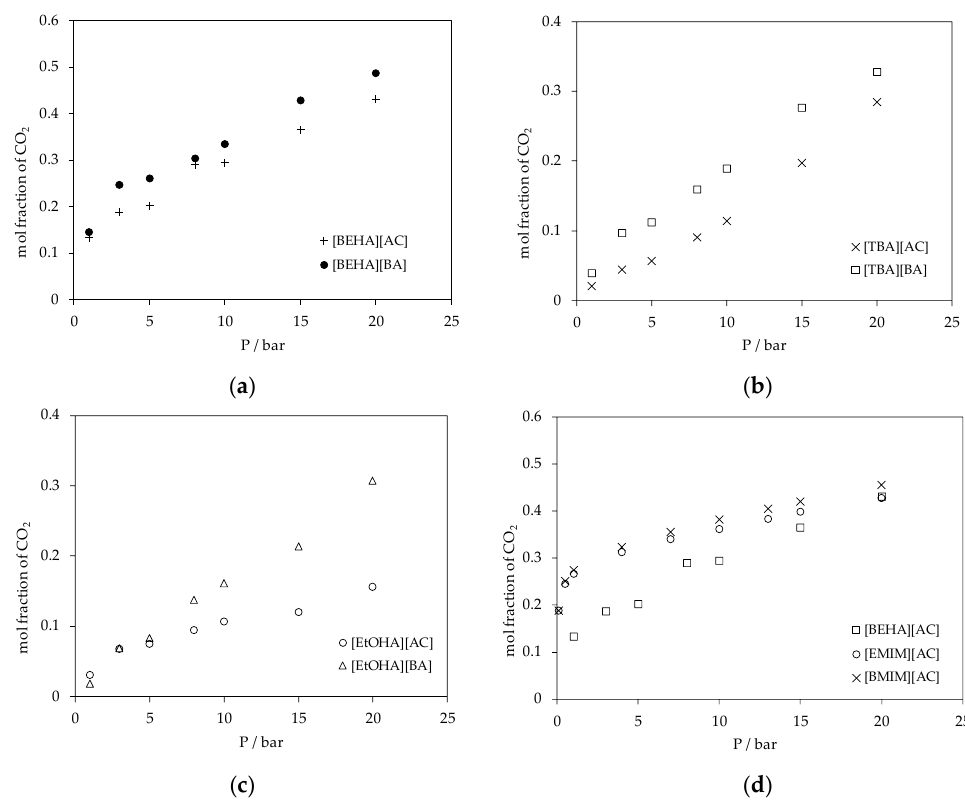
Figure 9. ( a ) Plot of CO 2 absorption in ammonium-based protic ionic liquids with the [BEHA] cation; ( b ) plot of CO 2 absorption in ammonium-based protic ionic liquids with the [TBA] cation; ( c ) plot of CO 2 absorption in ammonium-based protic ionic liquids with the [EtOHA] cation and; and ( d ) plot of CO 2 absorption in [BEHA][AC], [EMIM][AC] [45] and [BMIM][AC] [46] at 298.15 K.